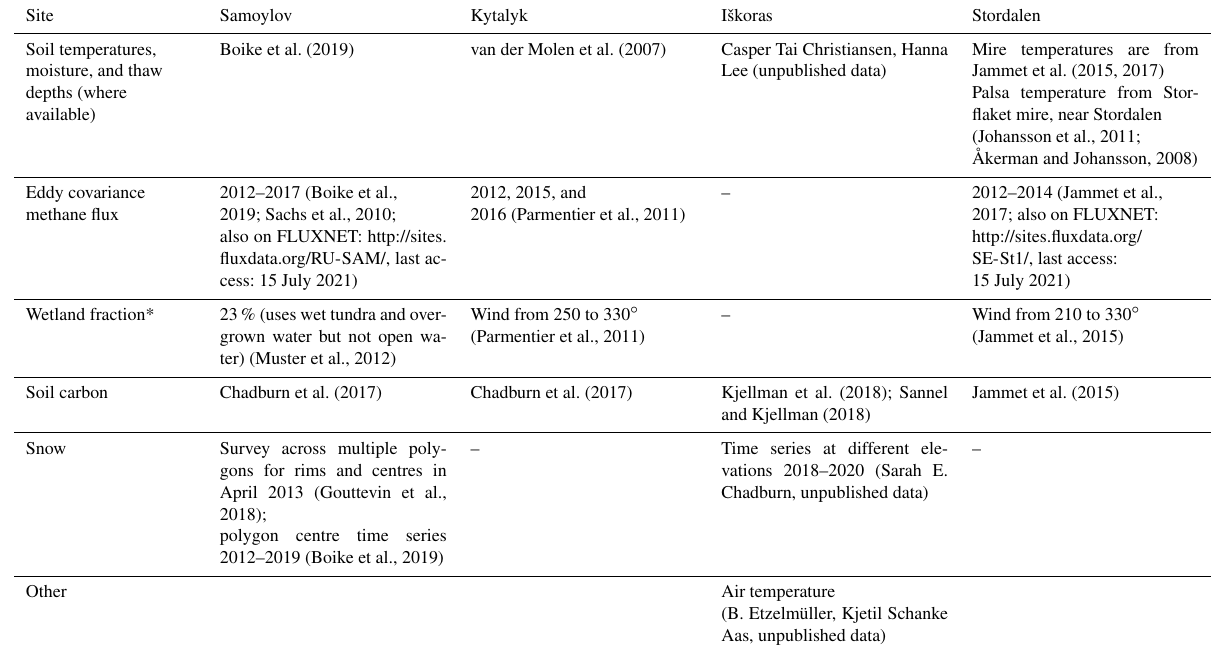
Table A2. Sources of site